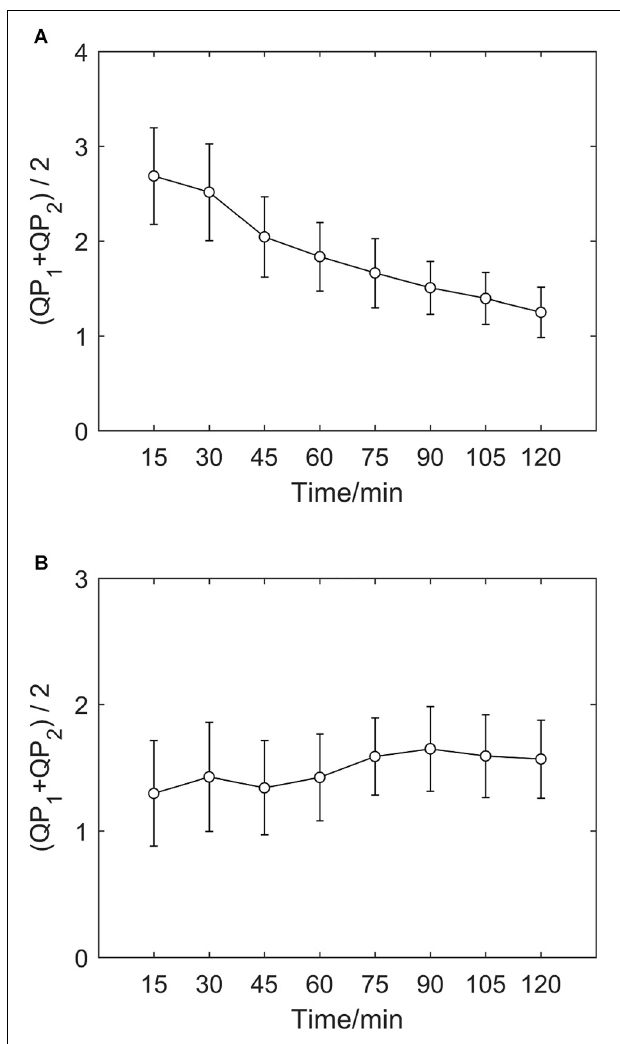
FIGURE 3 | Average value error bar chart of QP 1 and QP 2 of two groups. (A) Error bar chart of hypoxic group. (B) Error bar chart of MIT normoxic